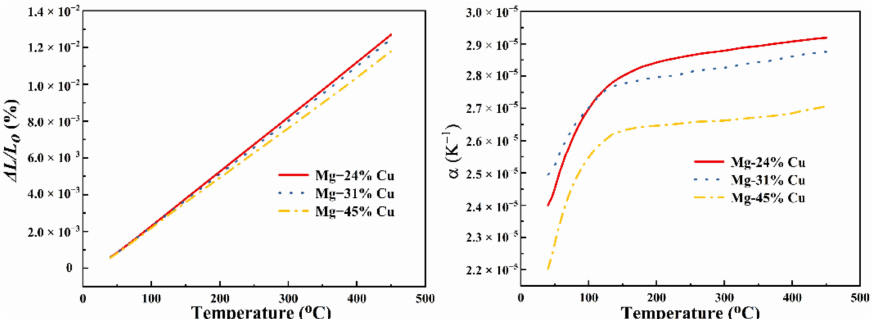
Figure 4. The temperature dependence of thermal expansion of Mg–Cu alloys: ( a ) relative elongation and ( b ) linear thermal expansion